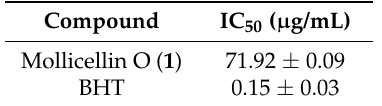
Table 5. Antioxidant